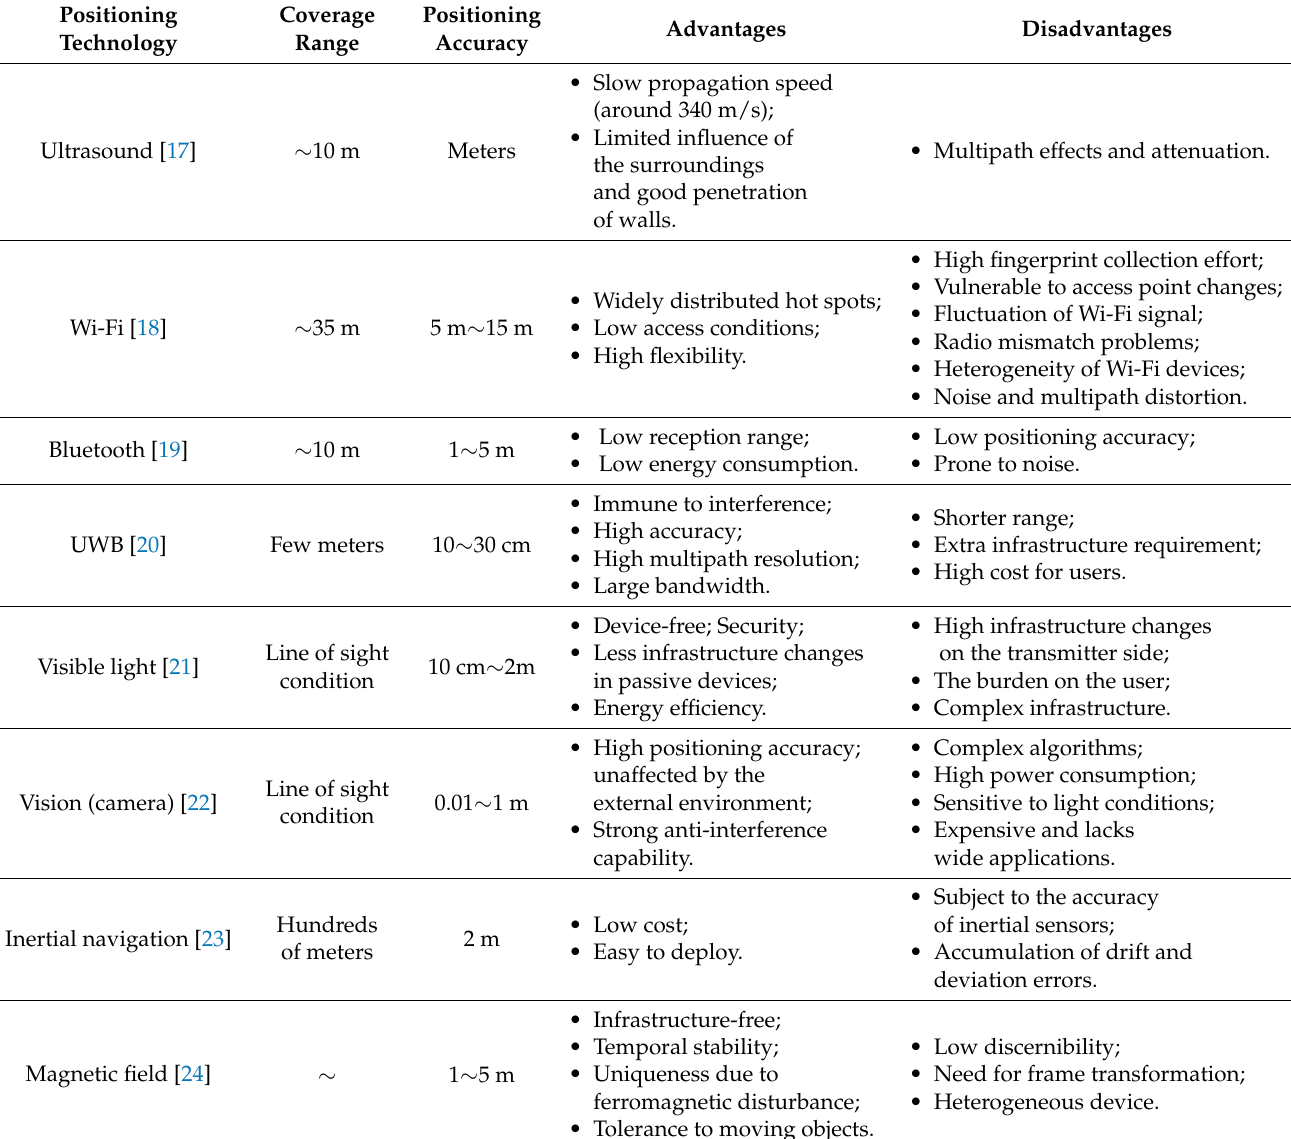
Table 1. Advantages and disadvantages of indoor positioning